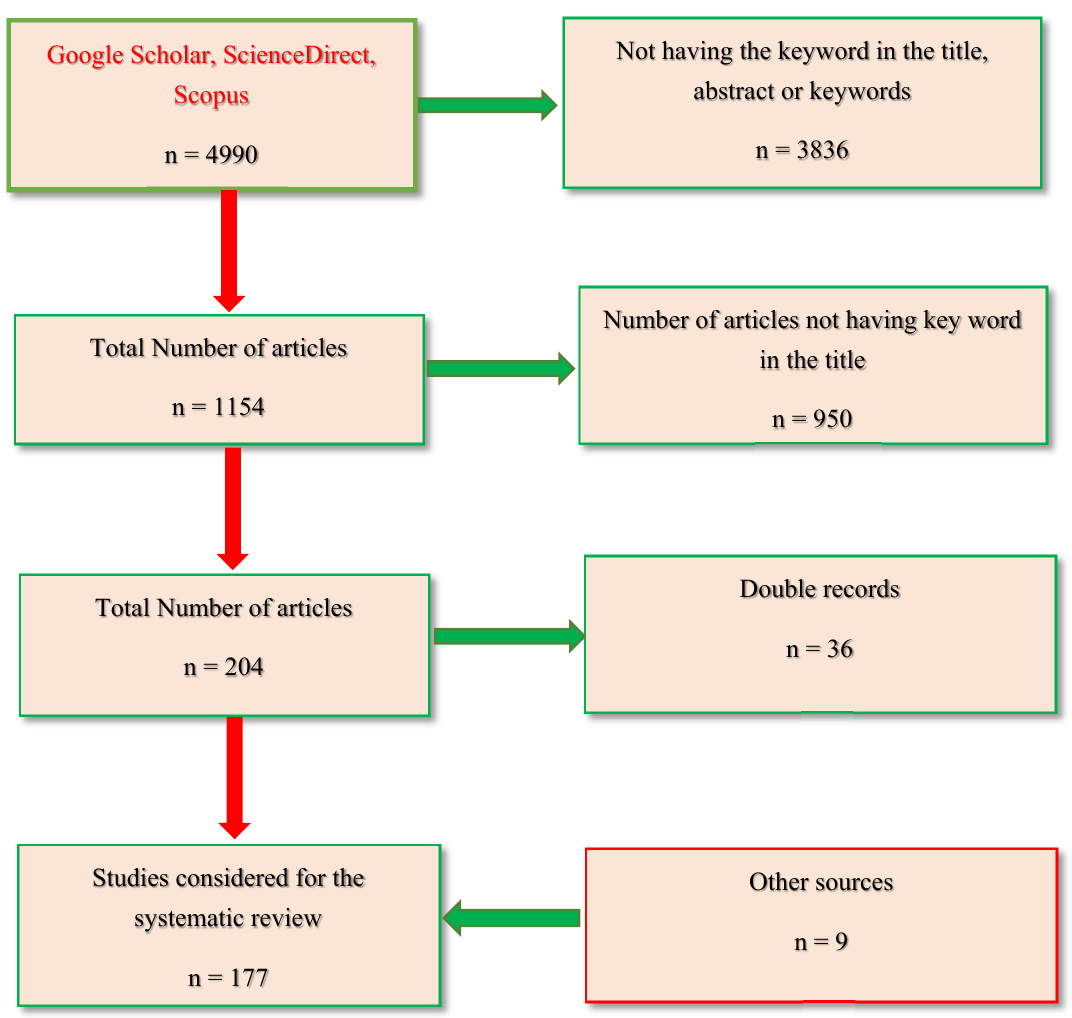
Figure 1. The number of published articles for land cover monitoring using Sentinel ‐ 2 images and the refinement processes.